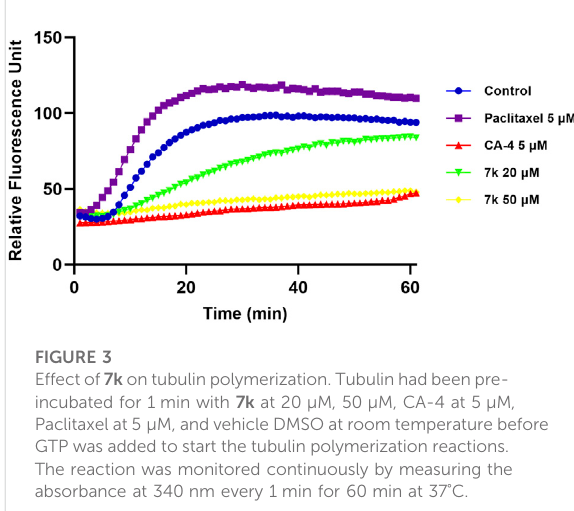
FIGURE 3 Effect of 7k on tubulin polymerization. Tubulin had been pre- incubated for 1 min with 7k at 20 μ M, 50 μ M, CA-4 at 5 μ M, Paclitaxel at 5 μ M, and vehicle DMSO at room temperature before GTP was added to start the tubulin polymerization reactions. The reaction was monitored continuously by measuring the absorbance at 340 nm every 1 min for 60 min at 37 °